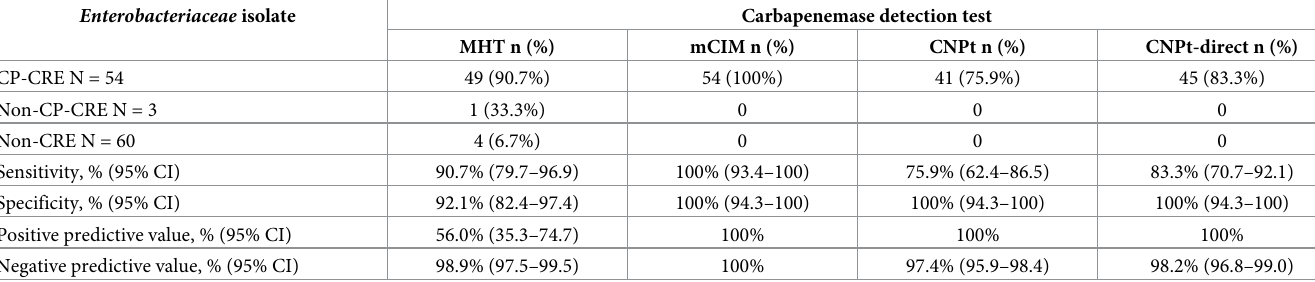
Table 1. Sensitivity, specificity, positive and negative predictive values of four carbapenemase detection tests. Enterobacteriaceae isolate